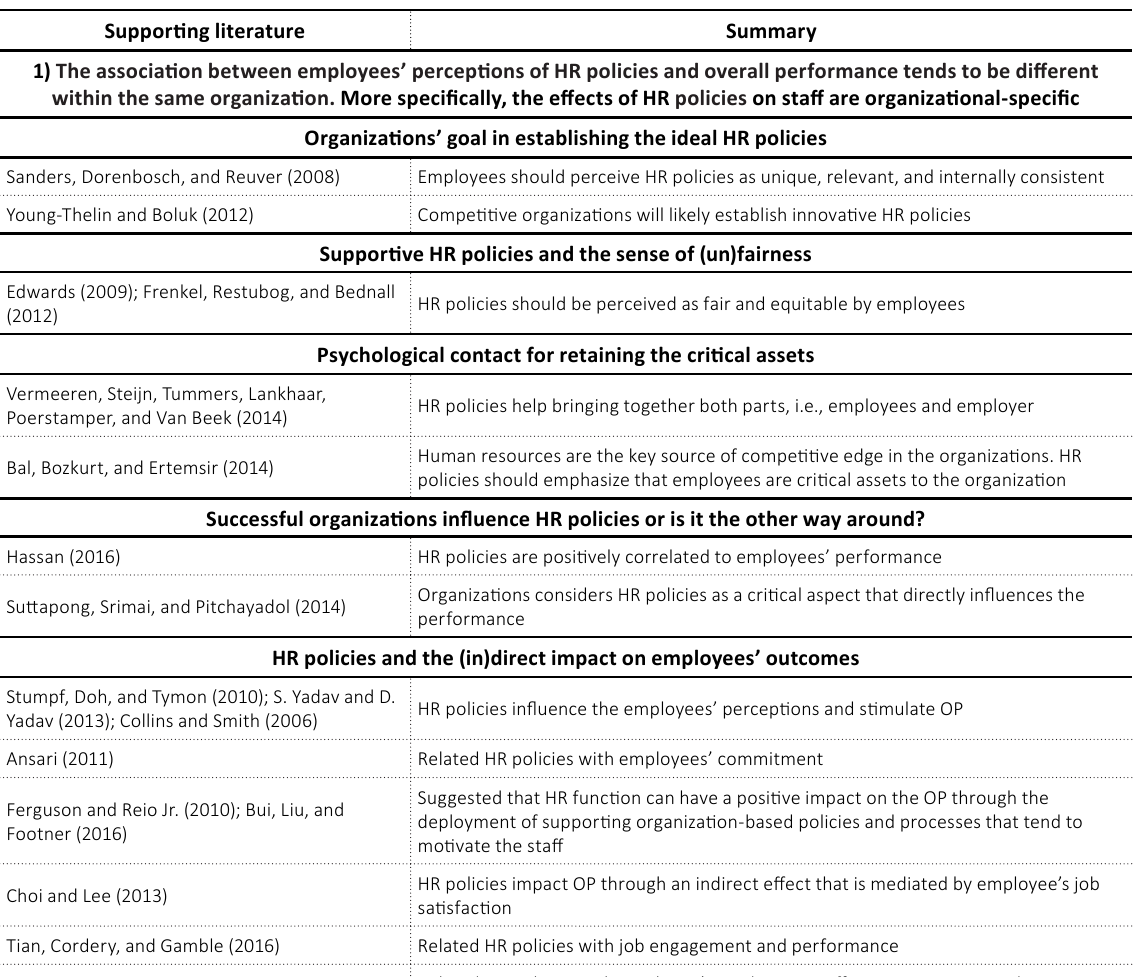
Source: Developed by